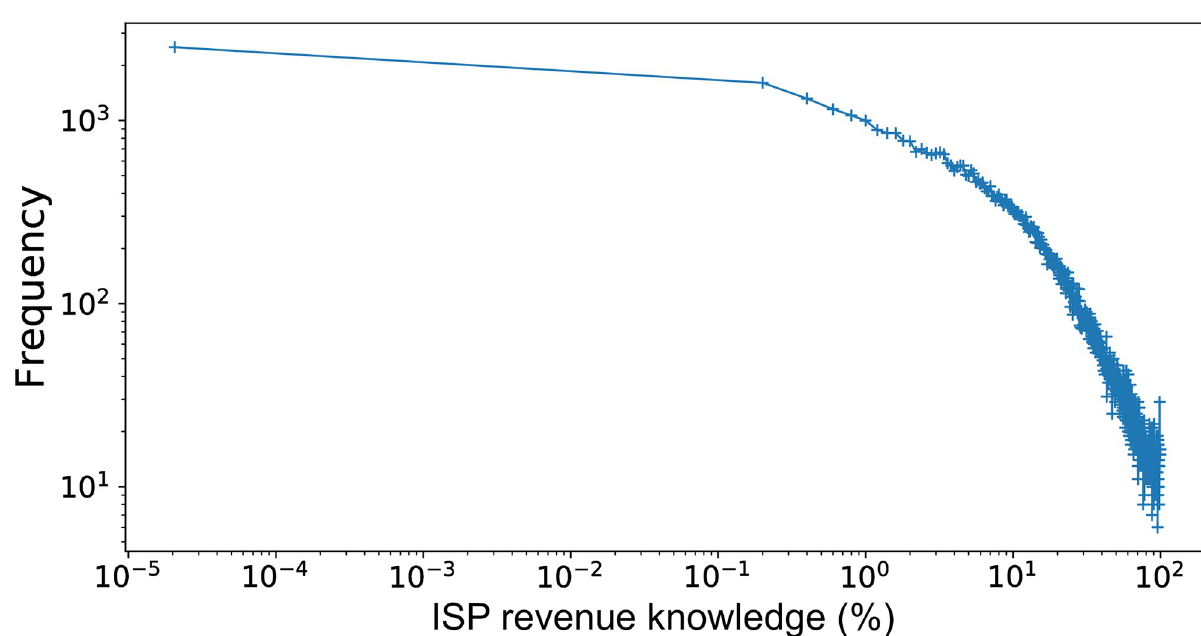
Fig 4. Distribution of the relative knowledge of the volume of transactions in comparison with the total revenue for the target perimeter.